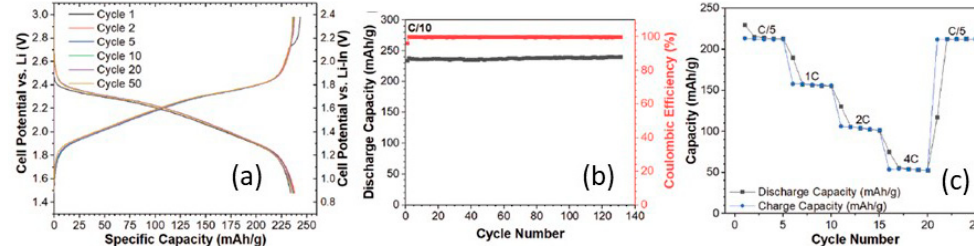
Figure 14. ( a ) Charge–discharge curves of Li-In|LIBOSS|TiS 2 all-solid-state battery cycled at C/10 at 25 °C and ( b ) cycling performance of the battery cycled at C/10 at 25 °C. C rate capability study: discharge capacity (black line), coulombic efficiency (red line). ( c ) cycling data at 60 °C at a rate of 1C. Reproduced with permission from [237]. Copyright 2020 Wiley.